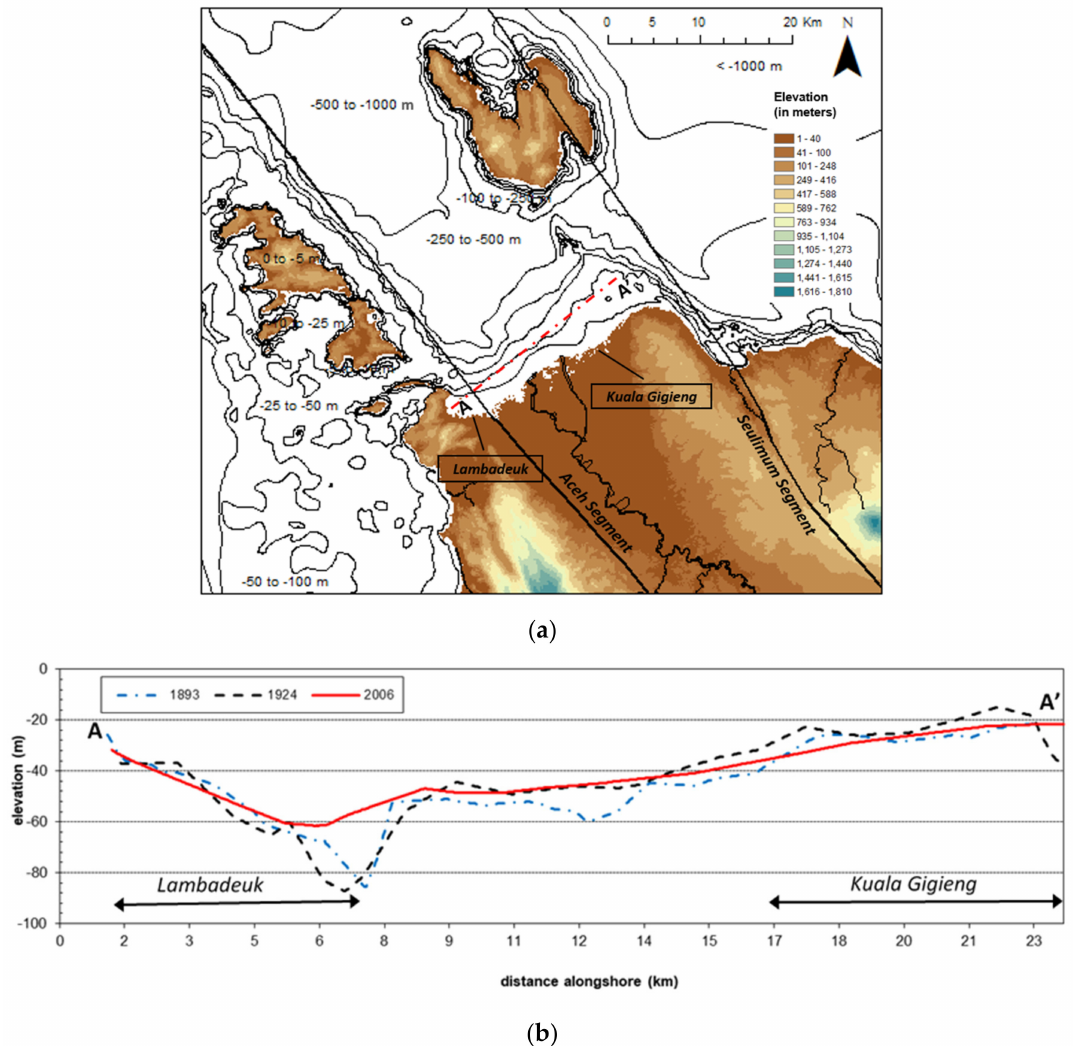
Figure 3. Banda Aceh is situated in the wedge between two tectonic fault segments of the Great Sumatran Fault System, i.e., the Aceh Segment on the southwest and Seulimum Segment on the northeast: ( a ) The map shows the topographic and bathymetric contours of the northern Sumatra region, and the two fault segments; ( b ) The multitemporal alongshore bathymetric profiles in front of Banda Aceh coast show higher elevation at Kuala Gigieng and lower down towards Lambadeuk. The bathymetric data of the year 1893 and 1924 was digitized from the Dutch Colonial Nautical Chart obtained from KITLV, and the 2006 bathymetry was obtained from the bathymetric survey conducted by UP-PSDA of Syiah Kuala